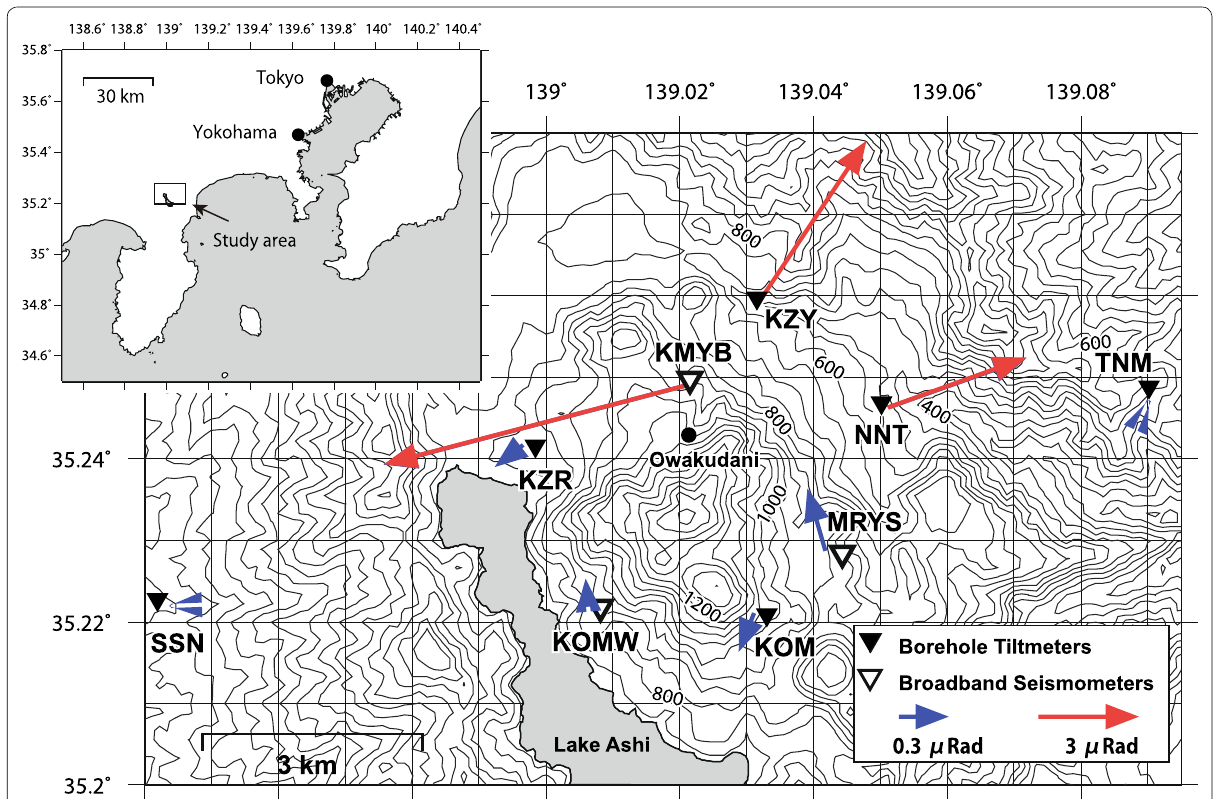
Fig. 1 Site distributions in and around Hakone volcano. The black triangles indicate the six permanent borehole stations; all but NTT were constructed by HSRI. NTT was installed and is operated by the Japan Meteorological Agency (JMA). The white triangles indicate the three broadband seismometers, which were installed as temporary stations. The red and blue arrows show static tilt changes observed on June 29, 2015 (Table 1). Note that the reference length for the red and blue arrows differs from each other. The black circle indicates the approximate area